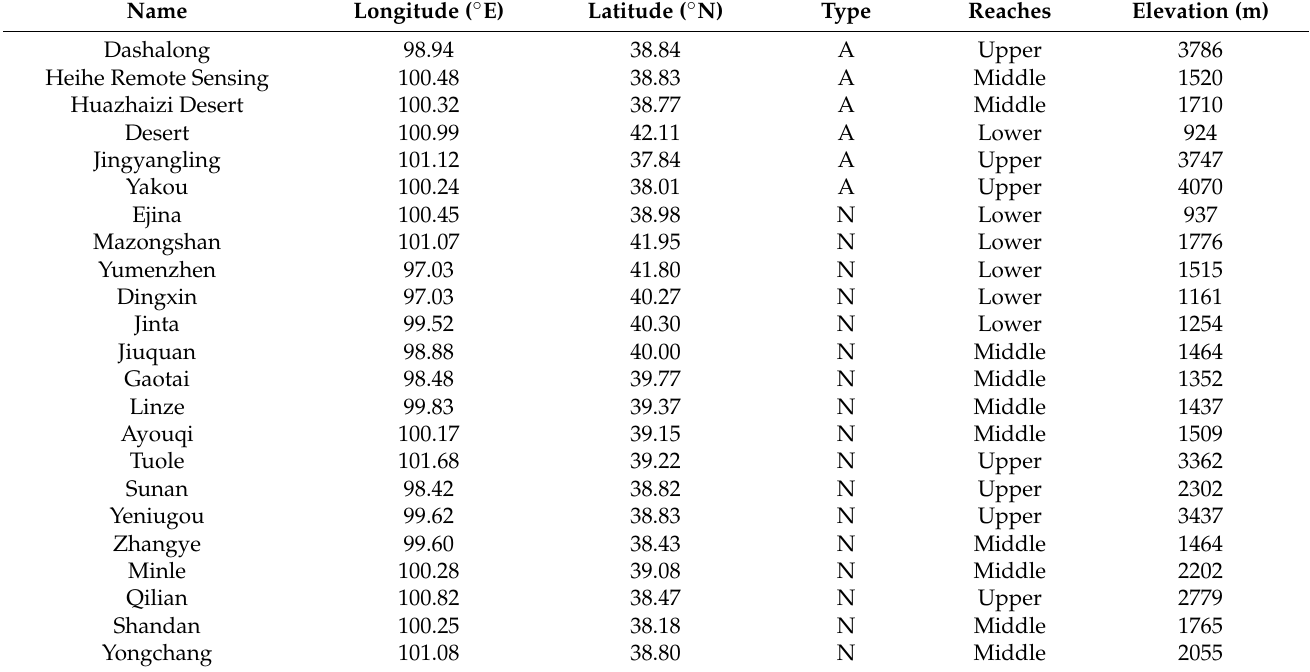
Table A1. Summary of the information regarding the stations over the HRB used in this study. In the description of type, N represents the national meteorological station and A represents the automatic weather station.